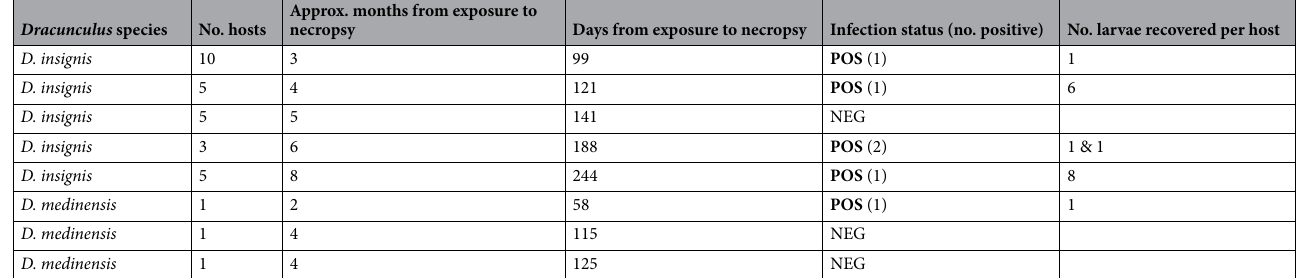
Table 2. Results of experimental infection and long-term persistence trials of African clawed frogs ( Xenopus laevis ) exposed by mouth (PO) to 50 copepods infected with third-stage Dracunculus insignis or Dracunculus medinensis larvae. All larvae recovered remained